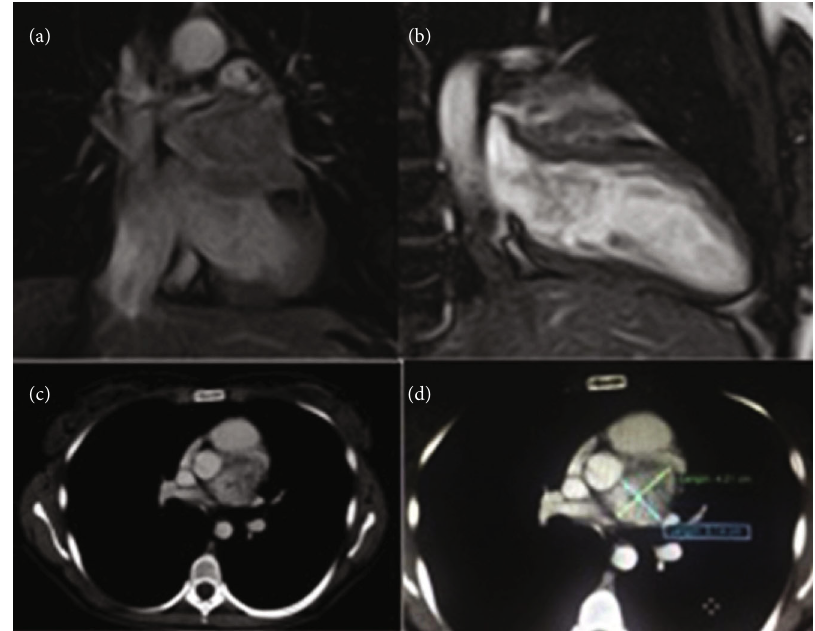
Figure 5: An example of Cardiac MRI with a cardiac paraganglioma [10]. (a) Coronal image with mass (isointense) in the area of the left atrium. (b) Two camber longitudinal view with the mass (isointense) in the left atrioventricular groove. (c, d) Axial view demonstrating the mass in relation to the aortic root (c) and pulmonary artery (d),